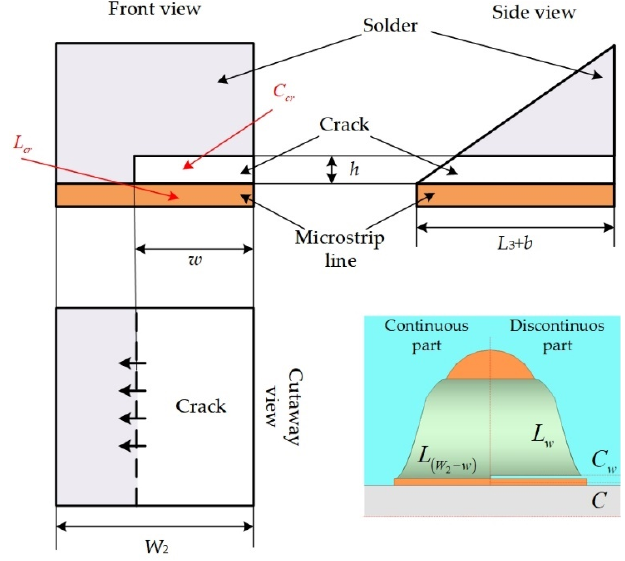
Figure 8. Simplified diagram of the cracked solder joint.